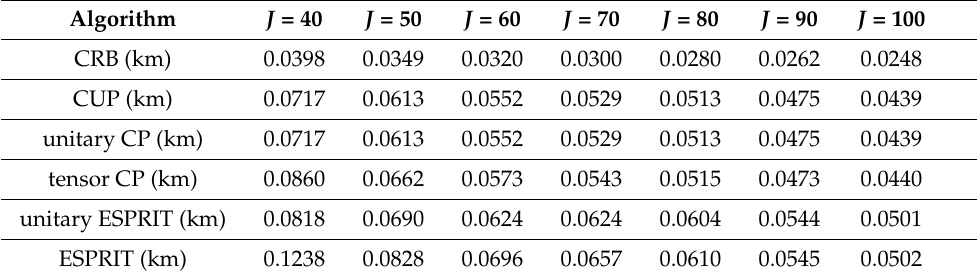
Table 6. RSME of range estimation versus Snapshots.